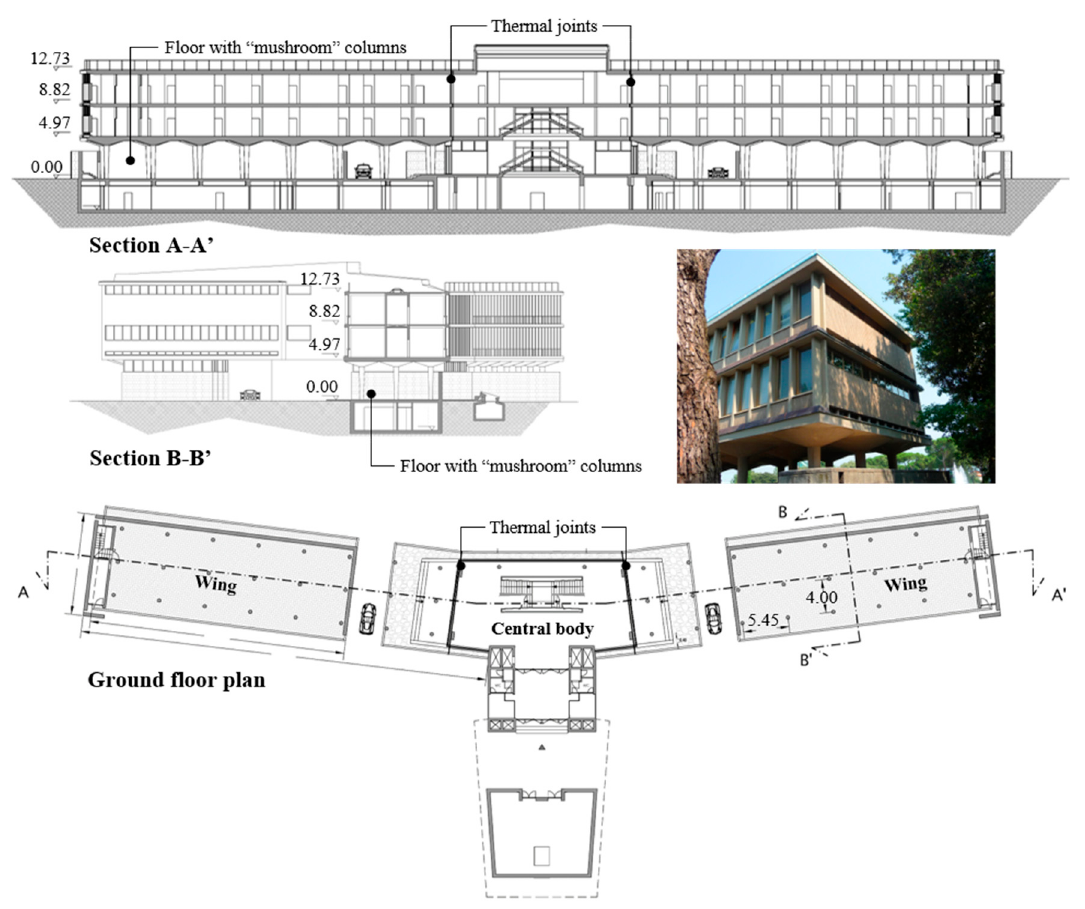
Figure 2. Plan, sections, and angular view of the building (all dimensions in m).